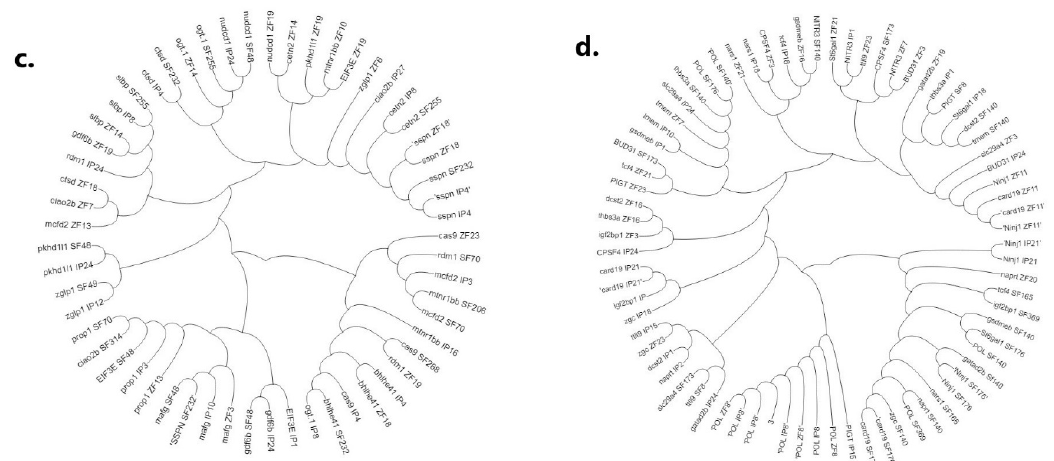
Figure 5. Phylogenetic trees constructed by neighbour-joining method based on p -distance of common genes present on chromosomes of channel catfish and zebrafish with C. magur scaffold: ( a ) SF_1; ( b ) SF_26, SF_75, SF_92; SF_254, SF_325, SF_530; ( c ) SF_48, SF_49, SF_70, SF_206, SF_232, SF_255, SF_268, SF_314; and ( d ) SF_8; SF_140, SF_165, SF_173, SF_176, SF_369.